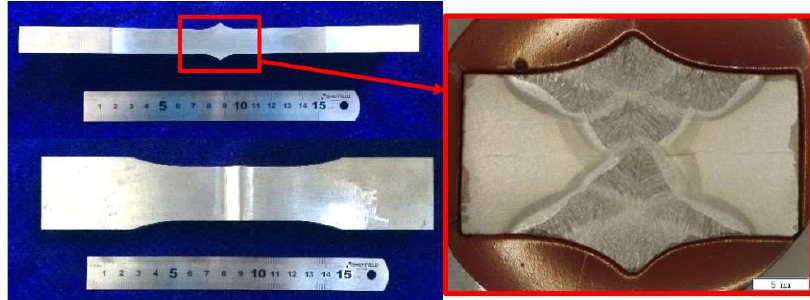
Figure 11. Macrograph of the weld.